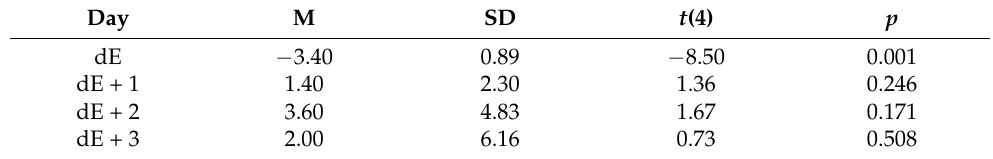
Table 3. Means and standard deviations of behavioral reactions to dairy products of Group 1 ( n =